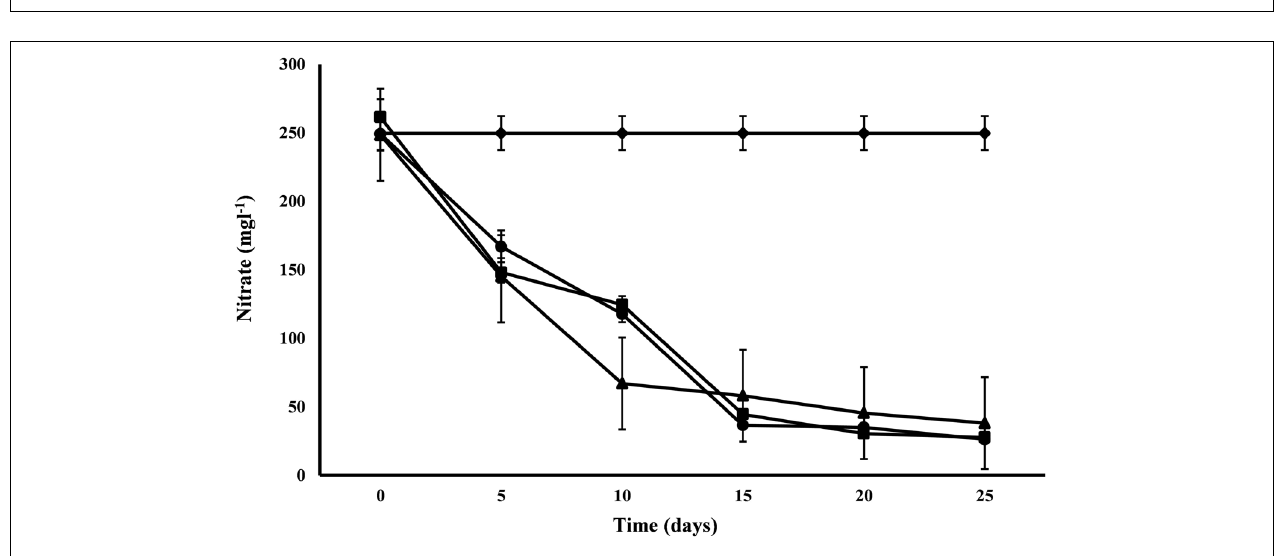
FIGURE 4 | Nitrate reduction at alternate of 5 days in 3:1 ratio of DWW treated with A. ambigua, C. pyrenoidosa and S. abundans ( (cid:7) -control; (cid:4) - C. pyrenoidosa ; (cid:78) - S. abundans